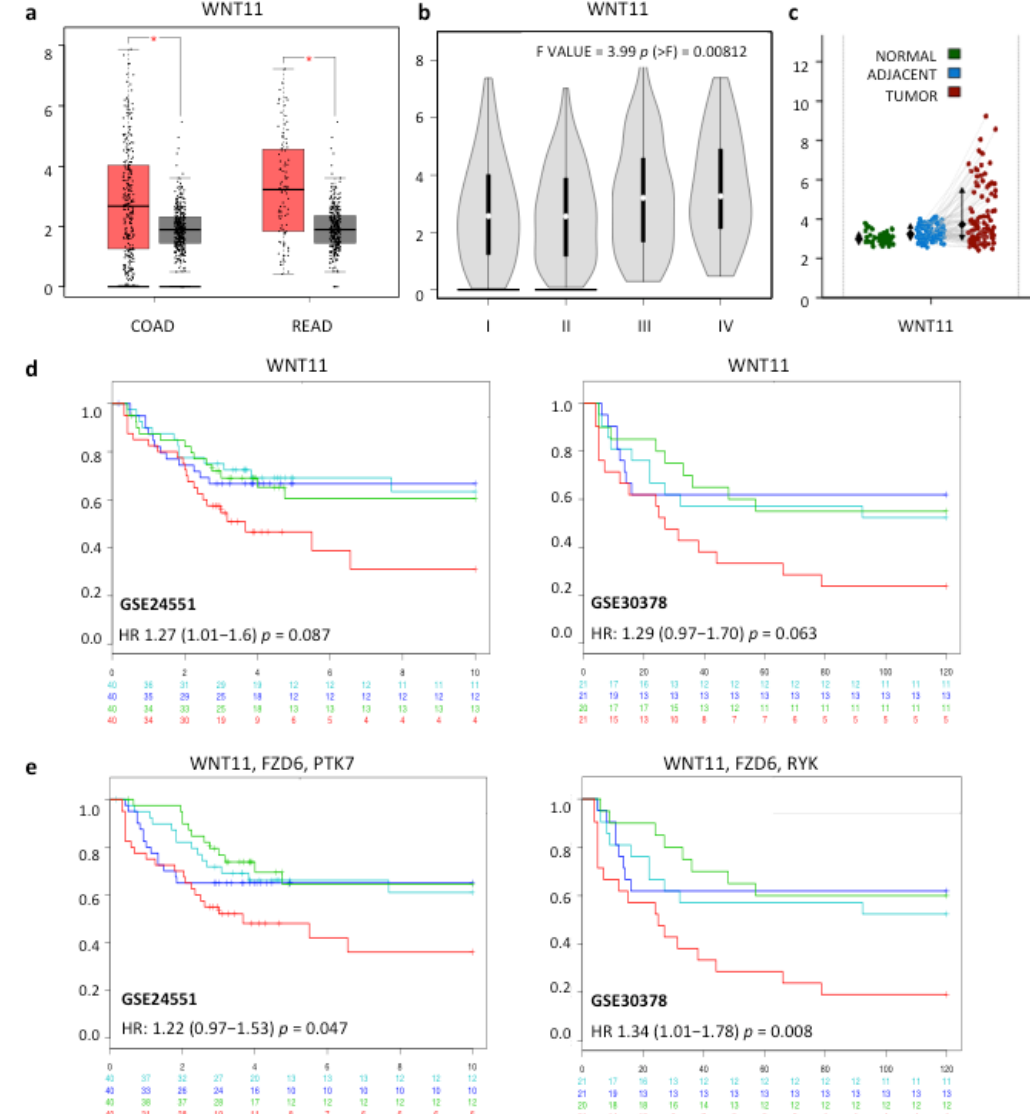
Figure 1. ( a ) Box plots comparing of WNT11 mRNA levels in normal / benign samples (from GTEx and TGCA, grey bars) and tumors (COAD and READ from TGCA, red bars) of the colon and rectum, respectively, analyzed using GEPIA, with fold-change set at 1.7 and p < 0.05; ( b ) Violin plots of WNT11 expression in the same COAD and READ TGCA datasets as in ( a ), according to stage of disease; ( c ) WNT11 expression in healthy colon mucosae (green, n = 50), normal adjacent mucosa (blue) and tumor(red) samples ( n = 98) from the GSE44076 dataset, analyzed using Colonomics; increased WNT11 in tumors versus normal p = 8.9 × 10 − 11 (ANOVA and Tukey’s test); ( d , e ) Kaplan–Meier plots showing disease-free survival for two patient cohorts (GSE24551 [21], n = 160 and GSE30378 [22], n = 83) analyzed stratifying expression into equal groups (red (highest), dark blue, light blue, green (lowest) using SurvExpress [23]. Log–Rank p -values and numbers of surviving patients over time (GSE24551 years, GSE30378 months) are indicated, HR, hazard ratio (95% confidence intervals) estimated by fitting a Cox PR using risk group as covariate.